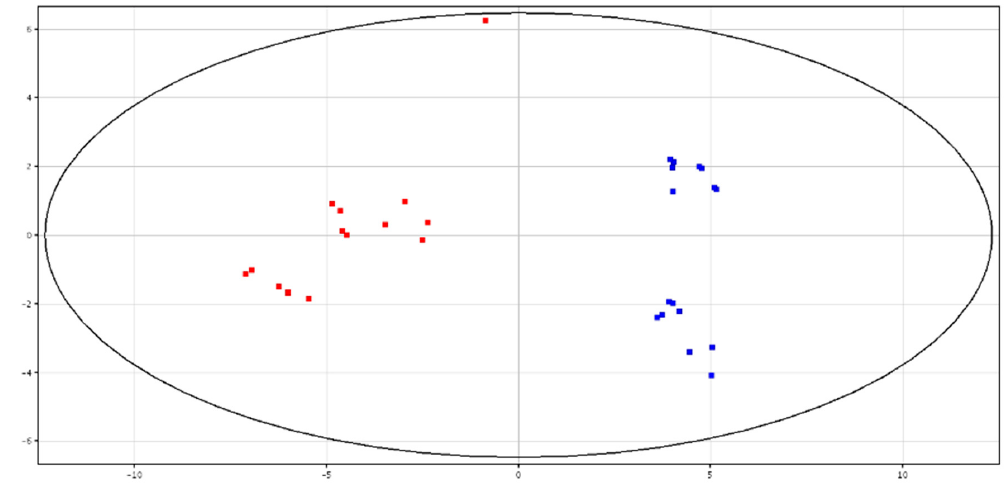
Figure 4. PCA scores plots of the LC–MS data acquired from cryopreserved seminal plasma for high (in red) and low (in blue) fertility bulls. PC1 ( x -axis) is 50.89%; PC2 ( y -axis) is 13.96%.